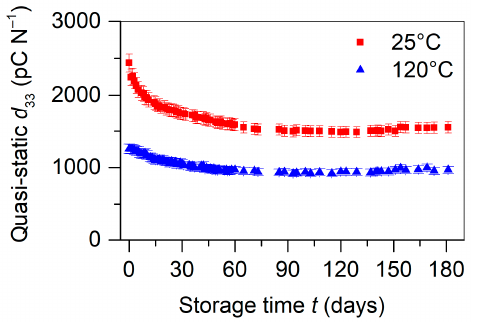
Figure 4. Isothermal decay of an averaged piezoelectric d 33 coefficient for five similar alternating FEP/TPU/FEP and FEP/air/FEP samples, all with a width ratio of 1, polarized at 25 and 120 ◦ C, re- spectively, and measured at room temperature. Measurements of the d 33 coefficients were performed at a static load of 1.2 kPa.